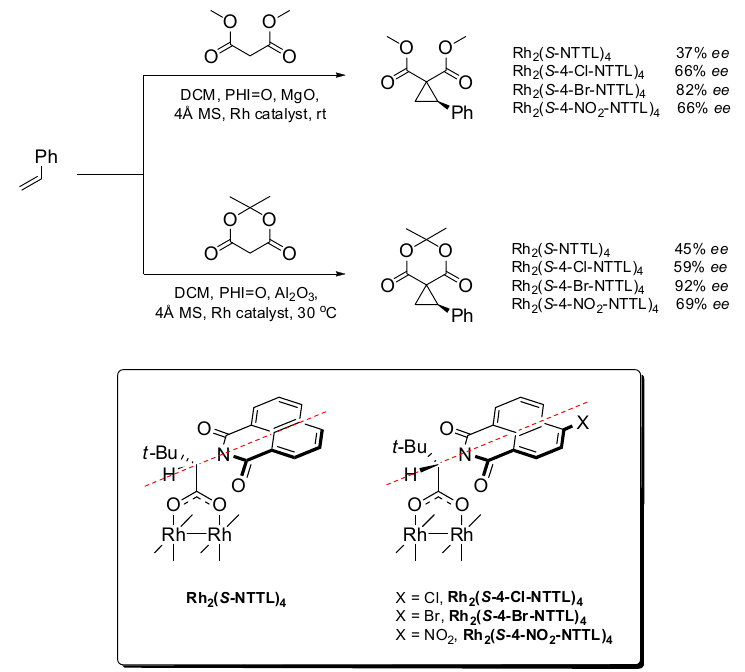
Scheme 8. Dirhodium(II)-catalyzed enantioselective cyclopropanation of styrene with dimethyl